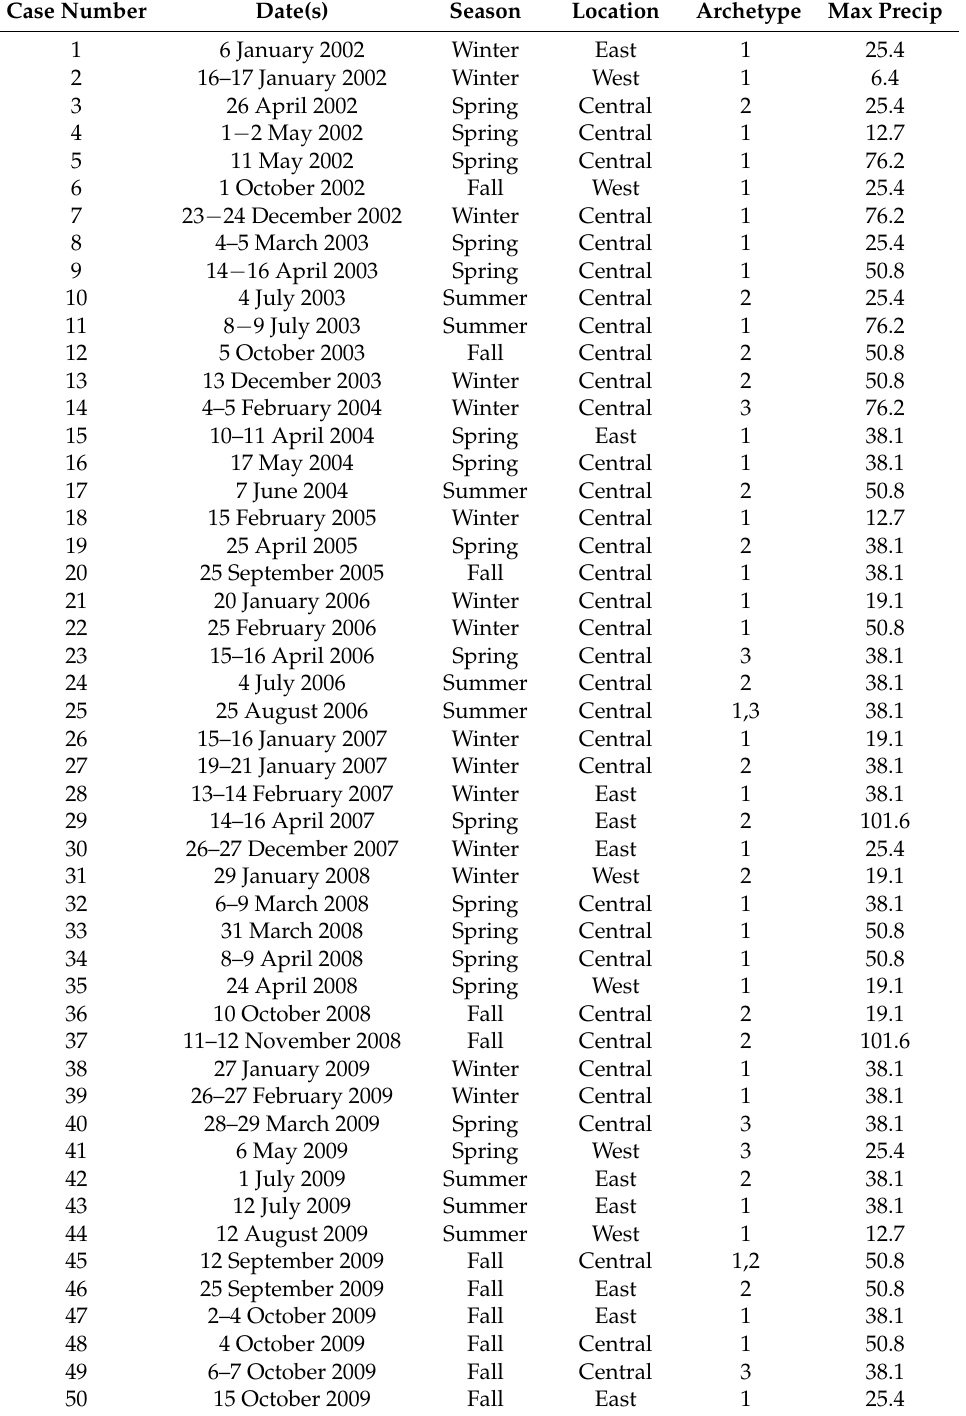
Table A1. List of cases included in the analysis. Included is the case number, date of occurrence, season, location, and archetype. Cases that were parallel stacked are Type 1, the 135 ◦ case is Type 2, and the 90 ◦ case is Type 3. The last column is the maximum precipitation (mm) contour found in the RRDOZ using the US Daily Weather Map series